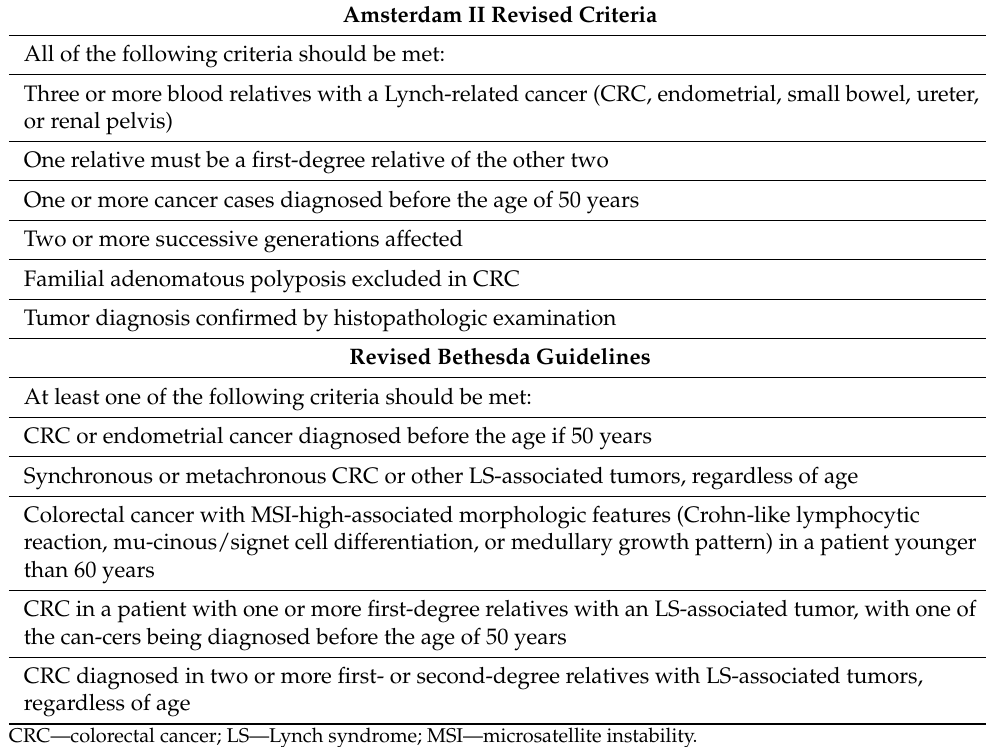
Table 1. Revised Amsterdam II criteria and Bethesda guidelines for the clinical diagnosis of Lynch